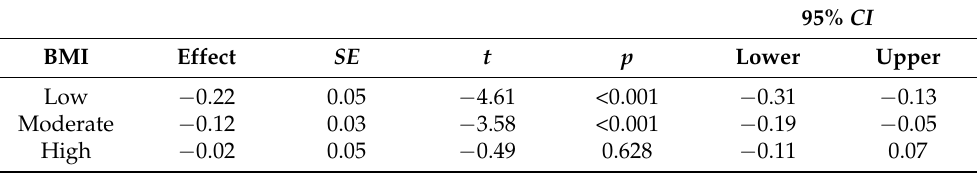
Table 4. Conditional effects of internal locus of control on the perceived effect of fitspiration images on self by